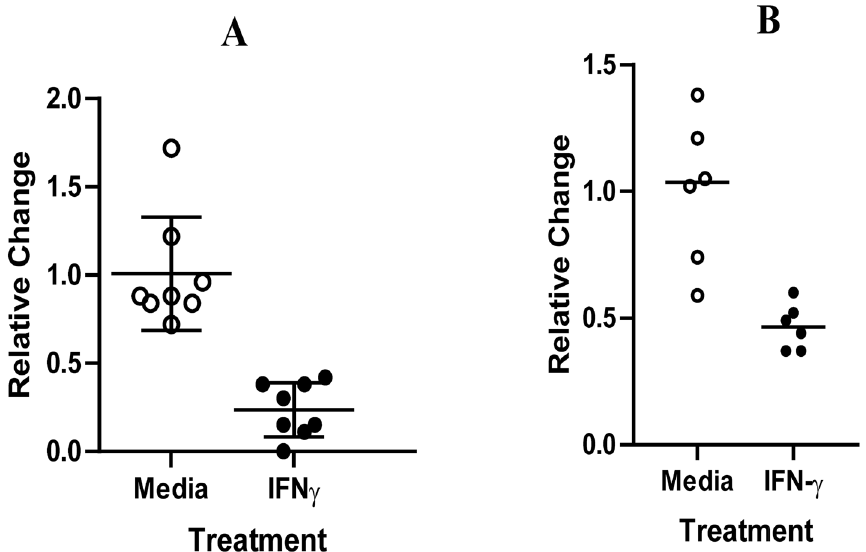
Figure 5. Treatment of epithelial cells with IFNγ limits attachment of O157. HEp-2 cells ( A ) and bovine intestinal epithelial cells (BIEC) ( B ) were either untreated (Medium only, open circles) or pretreated with recombinant bovine IFNγ (IFNγ, black circles) and subsequent O157 attachment assessed as described in Materials and Methods. ( A ) Results presented are the average of two independent assays, and each assay included four wells. Bars are ± SD. **p < 0.01 determined by One-way ANOVA with Dunnet posttest, ( B ) The data is expressed relative to average attached O157 in media-only wells. Data is representative of two biological experiment (n = 2) and three technical